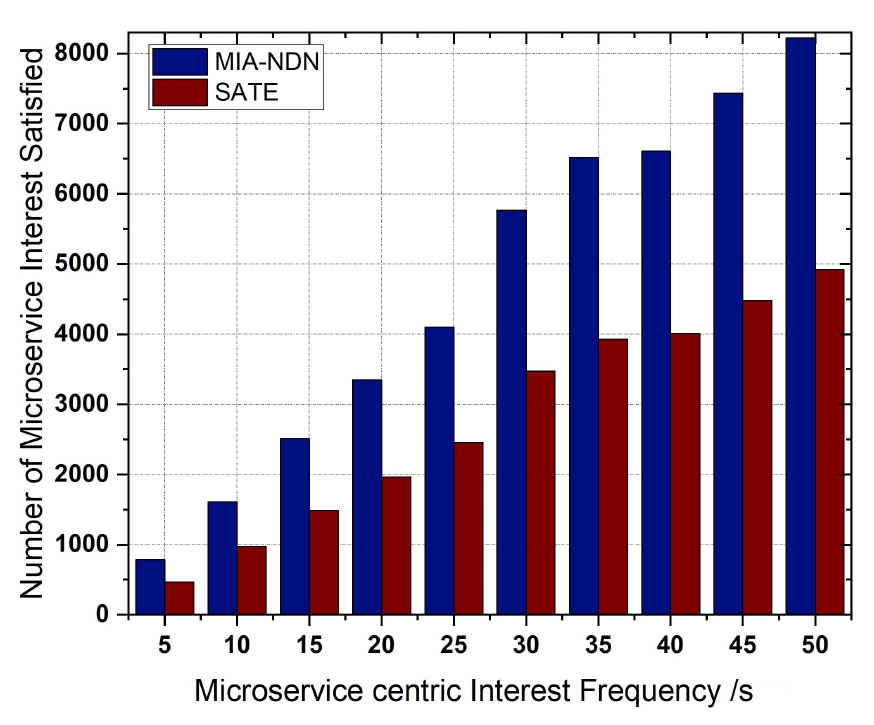
Figure 8. Microservice interest satisfaction as a function of microservice interest frequency. 3. Transmission overhead: Figure 9 shows the transmission overhead as a function of microservice-centric interest